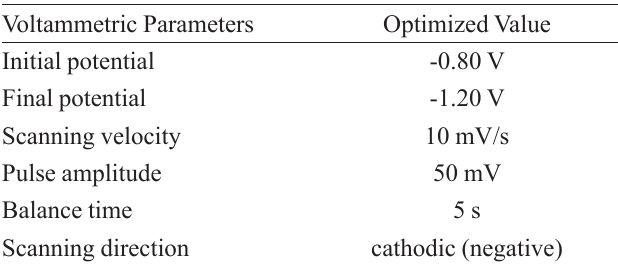
isoniazid and rifampicin in medicines by differential pulse